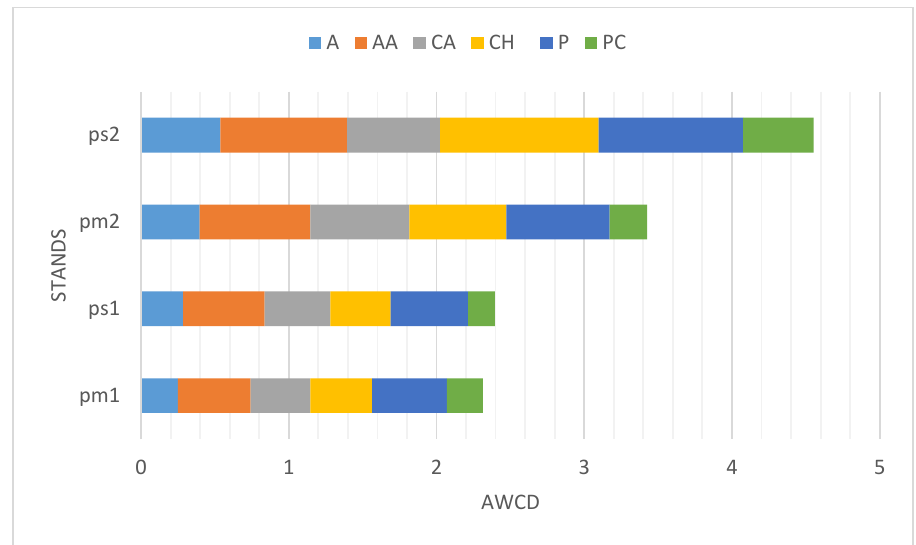
Figure 4. The AWCD of different microbial carbon-source groups in mineral soil (at 0 – 10 cm depth) around Pinus mugo and P. sylvestris stands at different sites. Stands: pm1: I-III sites of P. mugo ; ps1: I-III sites of P. sylvestris ; pm2: IV sites of P. mugo ; ps2: IV sites of P. sylvestris . Carbon substrate groups: